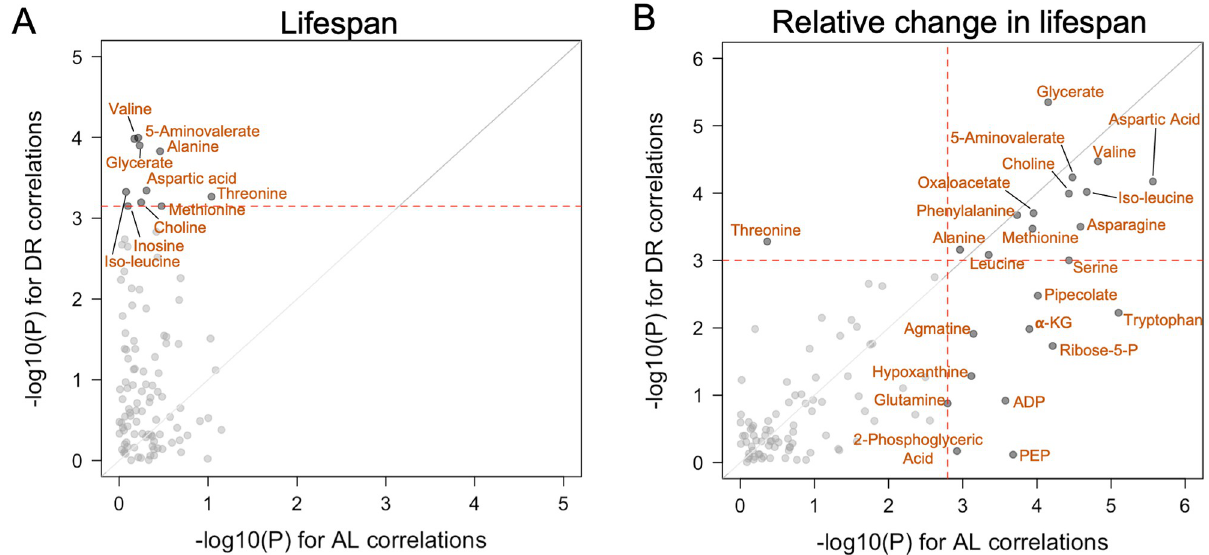
Fig 2. Metabolites significantly correlated with lifespan response. (A,B) Results of univariate analysis modeling lifespan phenotypes as functions of individual metabolites measured under either AL or DR were performed and -log 10 (p-values) were plotted. Each point represents a single metabolite and the significance of its association with (A) mean lifespan and (B) rLS. Red dotted lines represent FDR cutoff at α = 0.01.